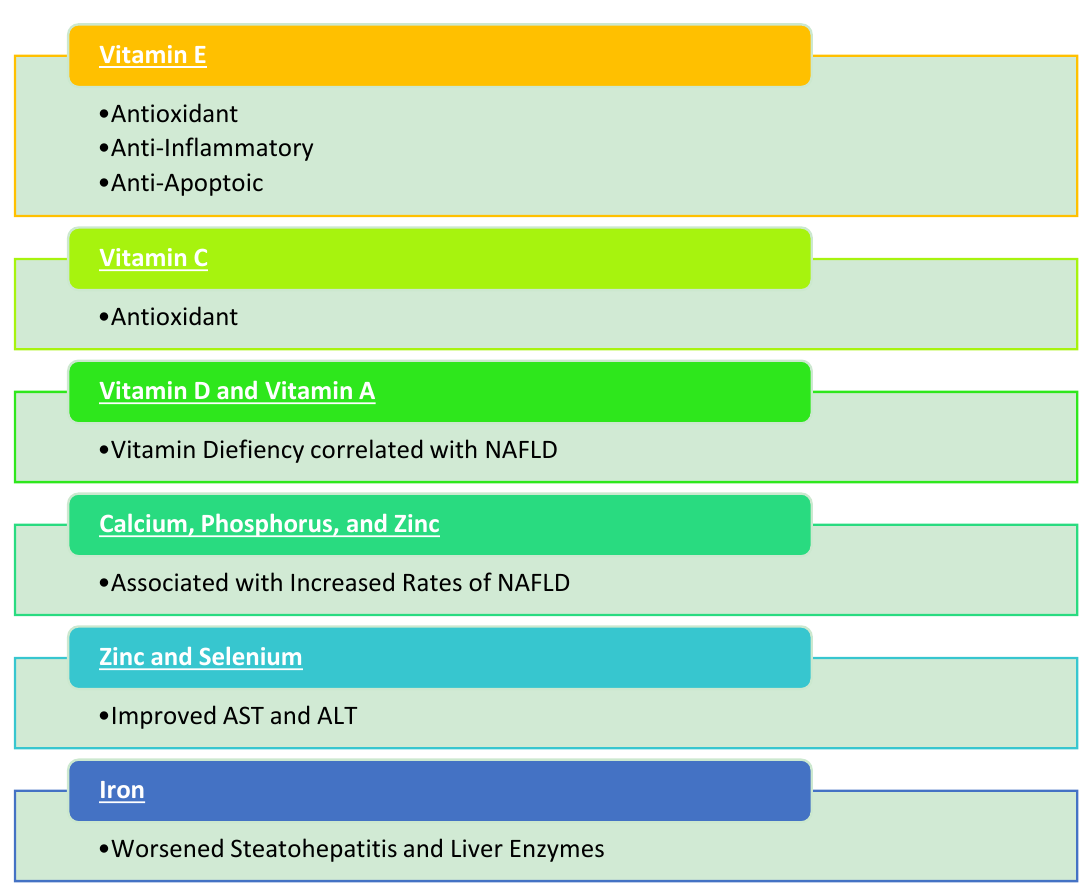
Figure 2. Summary of vitamins and minerals with nonalcoholic fatty liver disease (NAFLD).